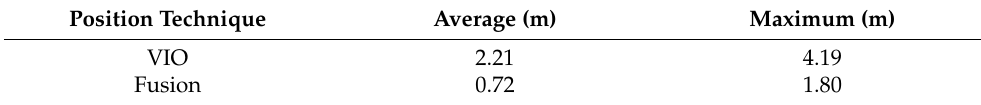
Table 4. Position error comparison of the covered corridor.